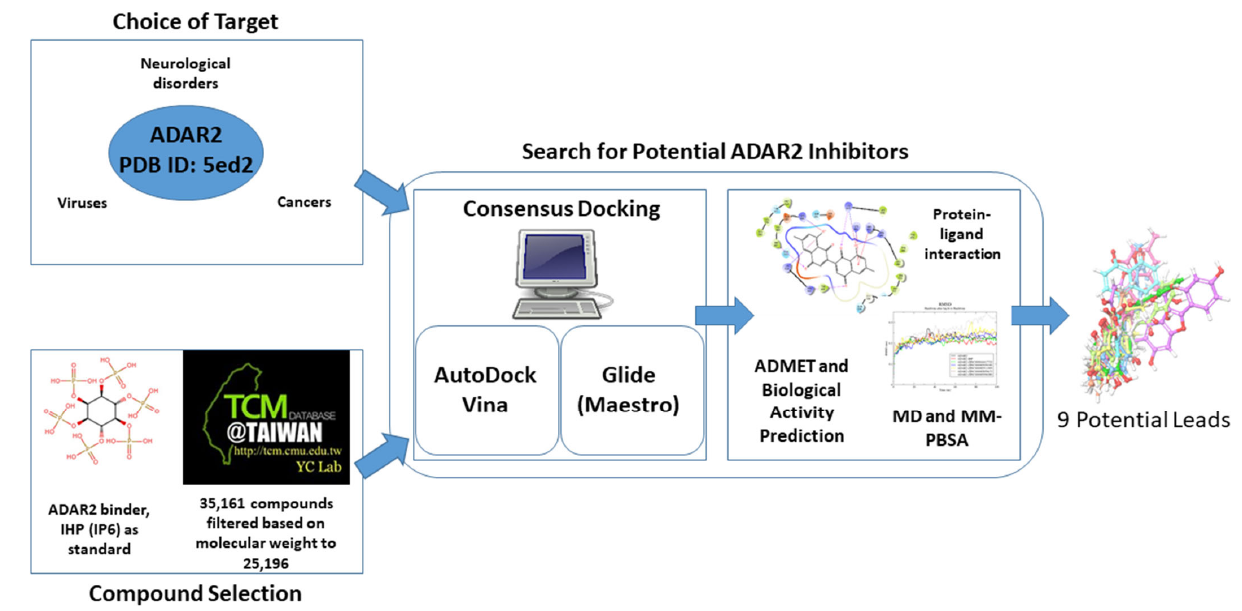
Figure 9. Schema detailing the step-by-step approach employed in this study to identify novel potential ADAR2 inhibitors.